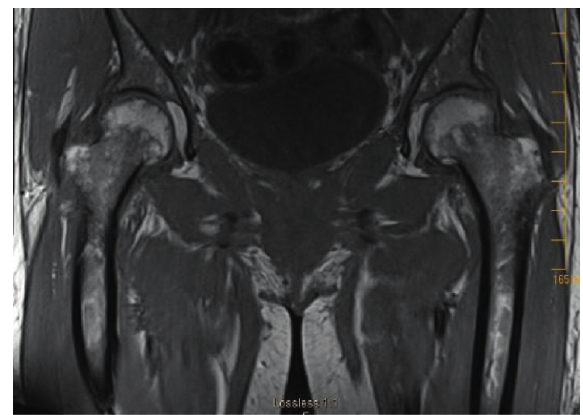
Figure 4: MRI pelvis revealed peripherally enhancing fluid col- lection extending into the adjacent soft tissues from the pubic symphysis consistent with septic arthritis. Left pubic body erosion without confluent marrow replacement indicates osteomyelitis. It also shows bilateral hip joint effusions with nonspecific left hip synovitis.